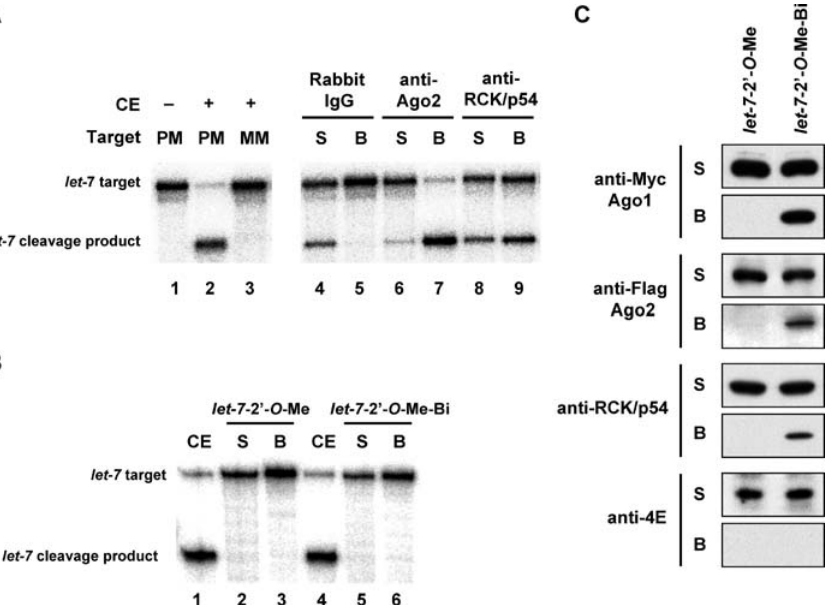
Figure 3. RCK/p54 Is a Component of Human miRISC (A) Affinity-purified miRISCs associated with PCK/p54 retain cleavage activity. To purify miRISC associated with RCK/p54, magnetic protein A beads coupled with rabbit IgG, rabbit anti-Ago2, or rabbit anti-RCK/p54 antibodies were incubated with HeLa cytoplasmic extracts. After immunoprecipitation, RISC activities were analyzed by incubating the supernatant (S) or bead (B) phases with 182-nt 32 P-cap-labeled let -7 substrate mRNAs having a perfectly complementary or mismatched sequence to the let- 7 miRNA. Cleavage products were resolved on 6% denaturing polyacrylamide gels. CE, cytoplasmic extract; PM, perfect match; MM, mismatch. (B) Affinity-purified miRISCs retain cleavage activity. let -7 miRISC cleavage of a perfectly matched RNA target was inhibited by 2 9 - O -Me